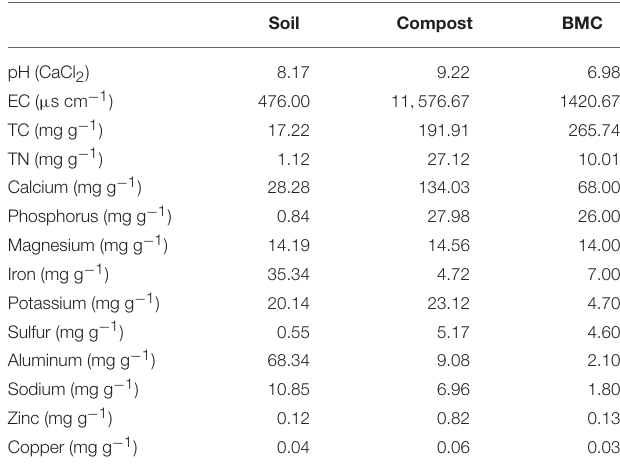
TABLE 1 | Basic properties of soil, compost and biochar–mineral complex (BMC) used in this study.